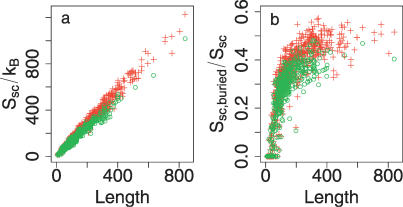
Side-Chain Entropy (SCE), Ssc, of 675 Nonhomologous Proteins in the PDB(A) Side-chain entropy versus chain length. Two results with α = 0.6 (red crosses) and 0.8 (green circles) are shown.(B) Percentage of SCE contributed by buried residues versus chain length.